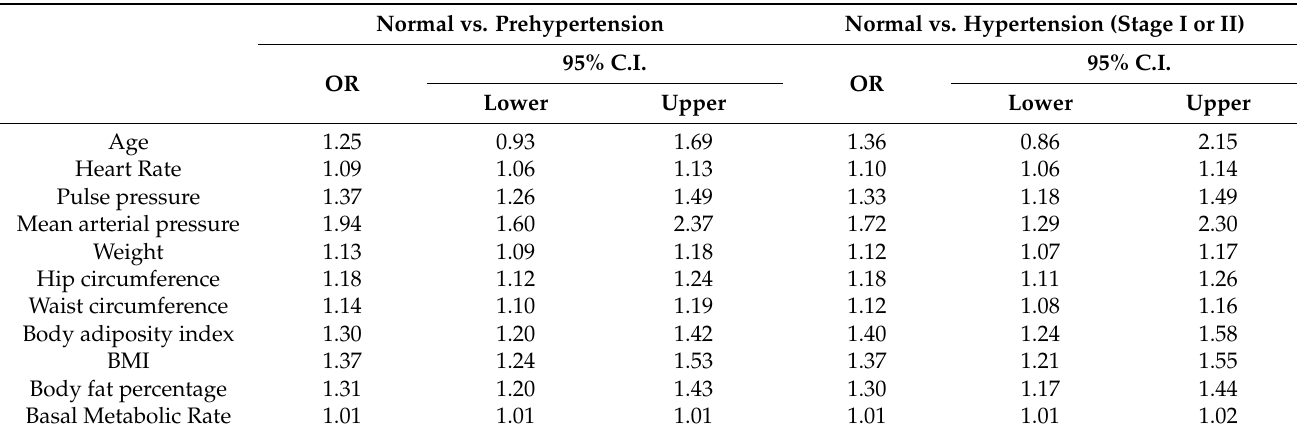
Table 3. Association between the study measurements and hypertension. Normal vs. Prehypertension Normal vs. Hypertension (Stage I or II) 95%